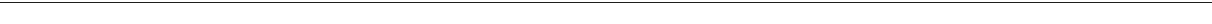
Fig. 5 dac and ato are required for T4/T5 neuron formation. a Schematic illustrating the expression of Ase (turquoise), Ato (red), and Dac (blue) in d-IPC Nbs during the fi rst (1) and second (2) competence windows and their progeny. b , c Dac (red) was expressed in all R9B10-Gal4 UAS-cd8GFP (green) labeled T4/T5 neurons in 3rd instar larvae ( b ). It was downregulated (arrowheads) in approximately 50% of adult T4/T5 neurons ( c ). d , e dac p7d23 -Gal4 UAS-cd8GFP (green) faithfully reported Dac (red, double arrowhead) expression in adults ( d ), speci fi cally labeling T4/T5 neurons innervating lobula plate (Lop) layers 1 and 2 ( e ). f Schematic illustrating Dac expression (blue) in adult T4/T5 neurons. g – j Unlike in controls ( g , i ), dac 1 mutant T4/T5 neurons adopted T2/T3 neuron morphologies with R9B10-Gal4 UAS-cd8GFP (green), displaying neurite extensions into medulla (Me) layer M9 (arrows) and more distal layers (arrowhead) ( h ), and UAS-brp-RFP labeled synaptic terminals (red, arrows) in lobula (Lo) layers 2 and 3 ( j ). k , l Unlike in controls ( k ), fas3 NP1233 -Gal4 UAS-cd8GFP (green)-mediated IPC-speci fi c simultaneous knockdown of dac and ato generated neurons that failed to form a four-layered lobula plate (Lop) neuropil and dendrites in medulla (Me) layer 10 and lobula (Lo) layer 1 ( l ). m , n Unlike in controls ( m ), Fas3-positive (red) T4/T5 neurons were absent following IPC-speci fi c simultaneous knockdown of dac and ato mediated by fas3 NP1233 -Gal4 UAS-cd8GFP (green) ( n ). For genotypes and sample numbers, see Supplementary Table 1. Scale bars, 50 μ m